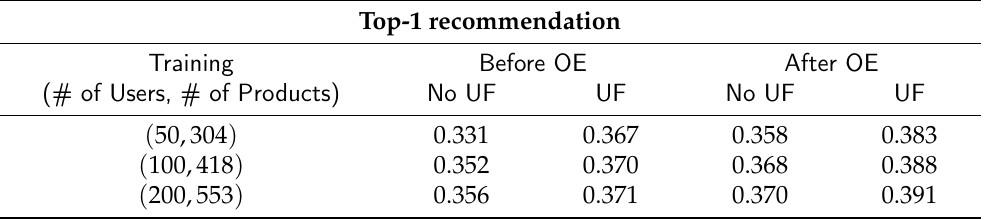
Table 6. Hit ratio with NCFO. Impact of the training dataset size and the ontology